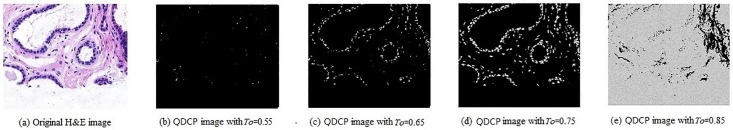
QDCP images generated under different thresholds TO with 8-point unit-radius circular neighborhood.Given a normal breast biopsy image (a) from the UCSB breast cancer dataset [41], a small threshold results in a QDCP image with large black area as most color changes are considered insignificant for image description (b); whereas with a large threshold, QDCP is sensitive to small color variations, and the major color change may be overwhelmed by small color variations (d). Since there are 36 rotation-invariant patterns under the setting, all QDCP images are normalized with respect to 36 for visualization.